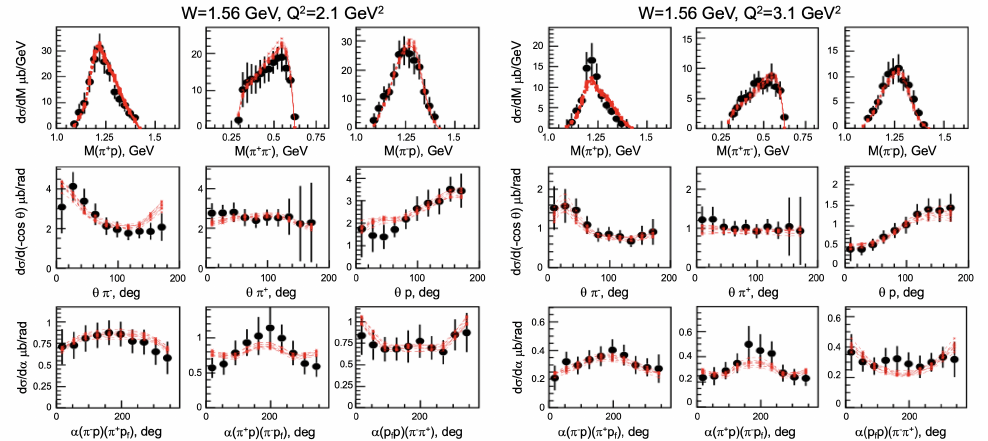
Figure 8. Regarding extraction of ∆ ( 1600 ) 3/2 + electrocouplings, representative examples of the nine independent one-fold differential cross sections available from the π + π − p measurements with CLAS [145,146] at two different Q 2 values, along with the data fits within the data-driven meson– baryon JM reaction model